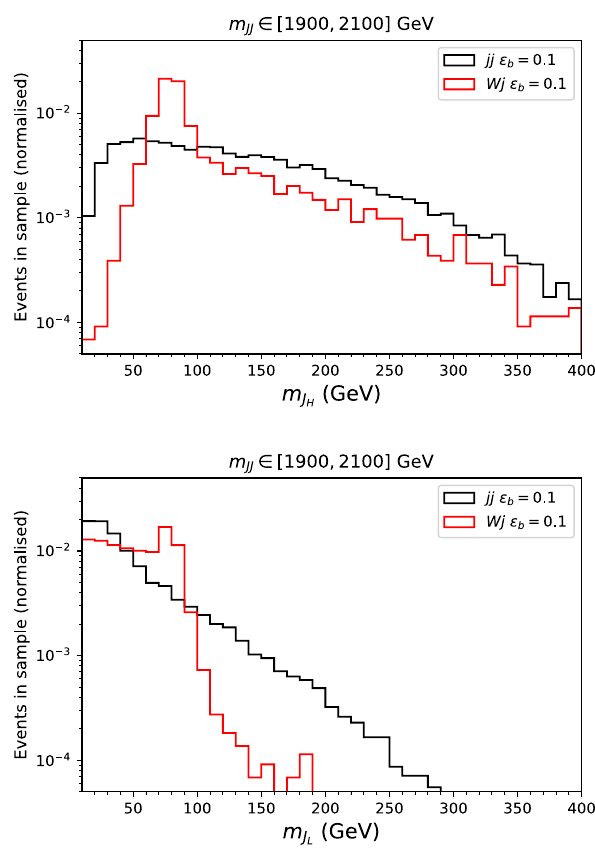
Fig. 15 Mass distribution of the two jets, ordered by mass, for jj and W j events with invariant mass in a narrow slice m JJ ∈ [ 1900 , 2100 ] GeV, after the application of the GenT x tagger and in- situ mass decorrelation with ε b = 0 .